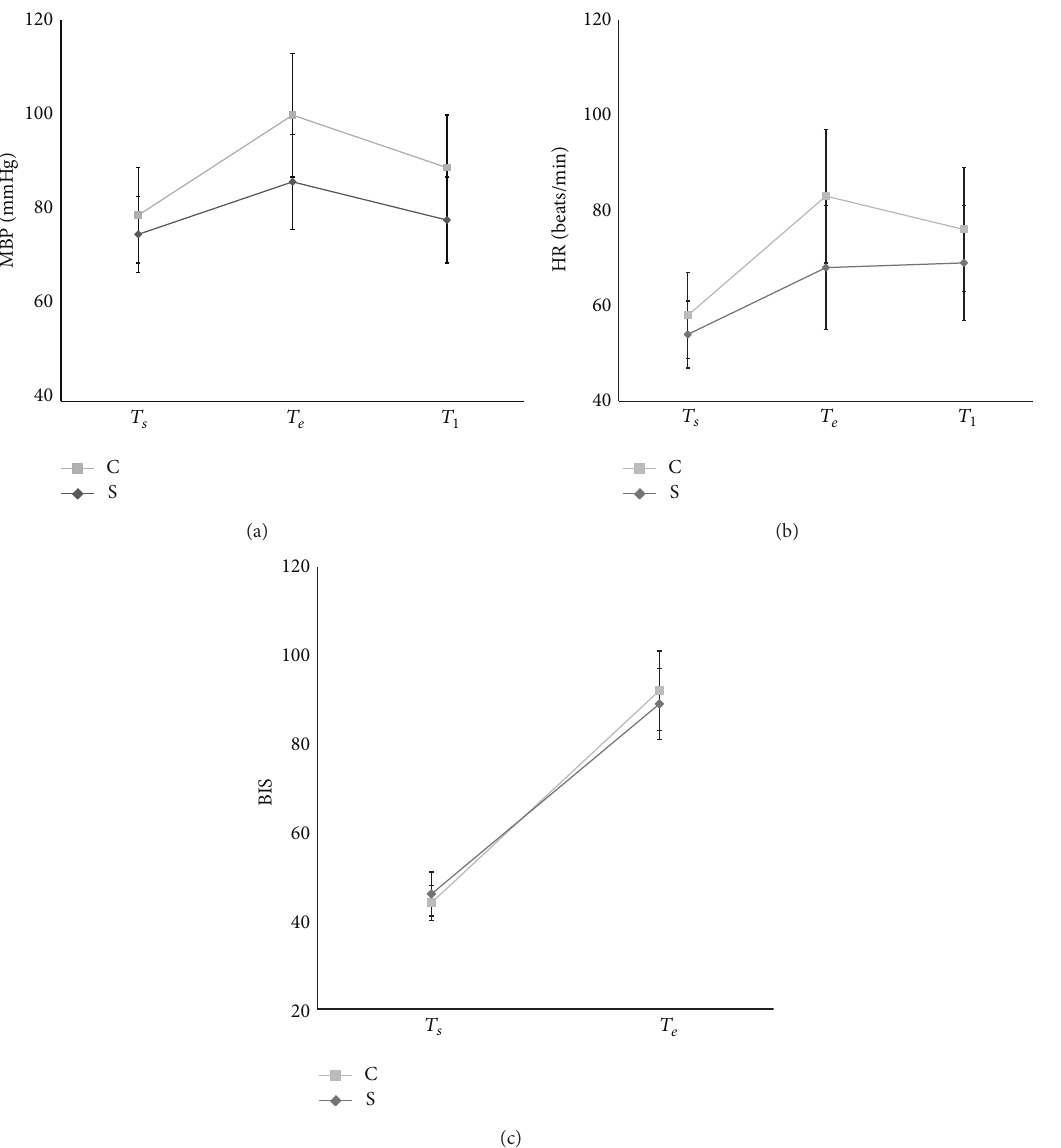
Figure2:Thehaemodynamicandneurologicchangesduringemergencefromanaesthesia.(a)Meansystemicbloodpressure(MBP),(b)heart rate (HR), and (c) bispectral index (BIS). Abbreviations: 𝑇 𝑠 , at initiation of sufentanil (S group) or normal saline (C group) administration; 𝑇1 , on arrival to the postanaesthetic care 𝑇 𝑒 , after extubation; and